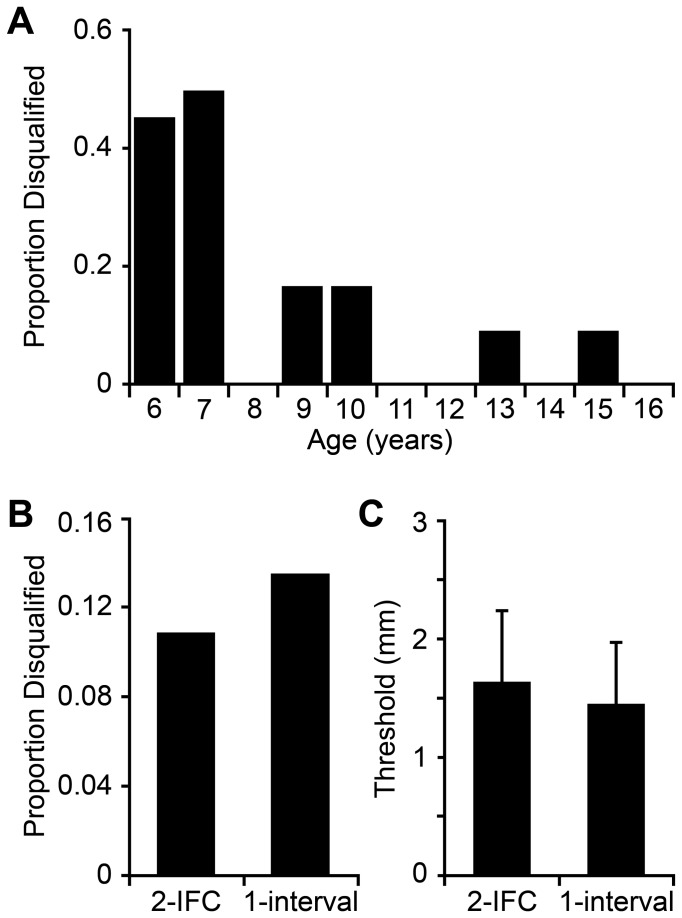
GBF disqualification analysis and comparison between testing protocols.(A) Proportion of participants in each age bracket for whom all four end-of-block GBFs exceeded the criterion value of 0.5. (B) Proportion of participants disqualified using the two testing protocols. (C) Average thresholds of qualifying participants on the two testing protocols (error bars: 1 SD).